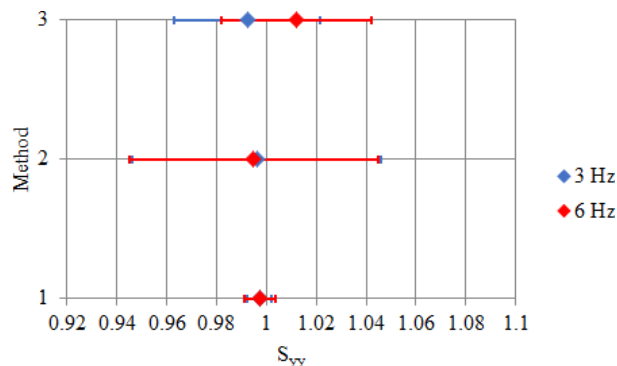
Figure 5. Piezo-electric accelerometer: comparison between meth- ods (main sensitivity along the z axis, S zz ).